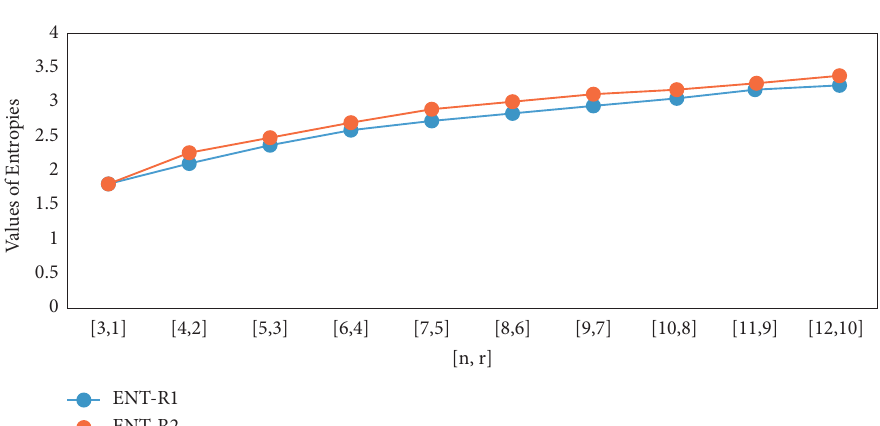
Figure 7: Comparison of Randic entropies for α � 1 and for α � − 1 for the coronoid system C